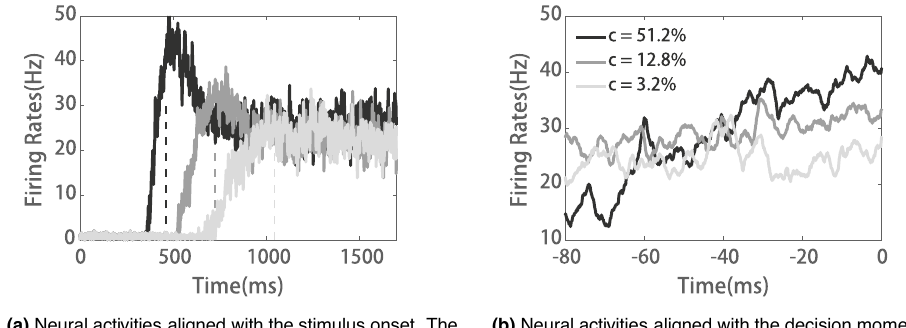
(a) Neural activities aligned with the stimulus onset. The vertical dashed lines indicate the decision moments. Figure 3. Activities of confidence neurons during decision